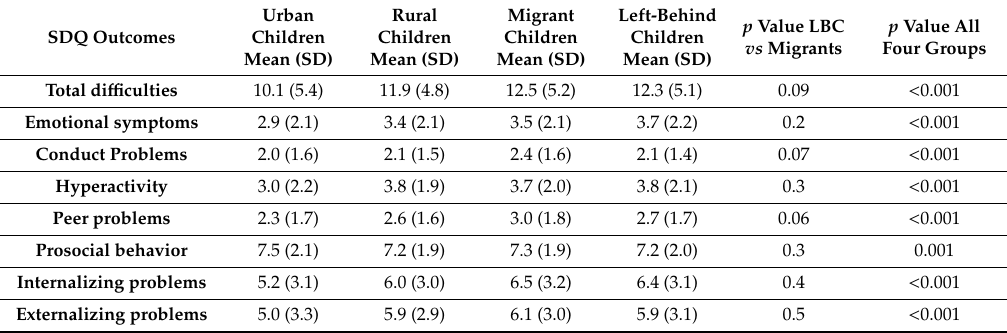
Table 2. Group di ff erences in self-reported version of the Strengths and Di ffi culties Questionnaire (SDQ-C) outcomes.